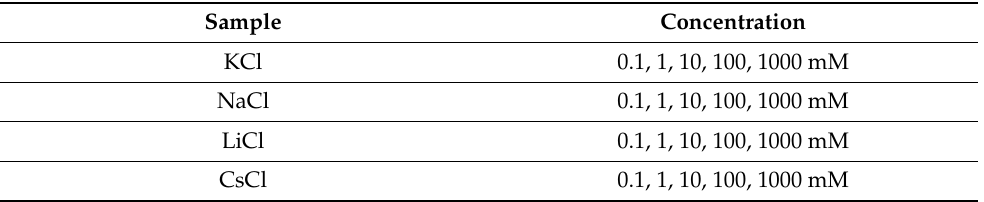
Table 2. Concentrations of alkali metal salts samples (solvent: pure water).